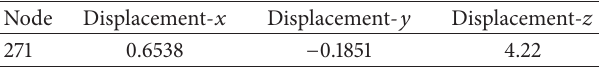
Table 8: The displacements (in m) at green nodes using the nonlinear FEM for the fourth experiment. The displacements at blue nodes are